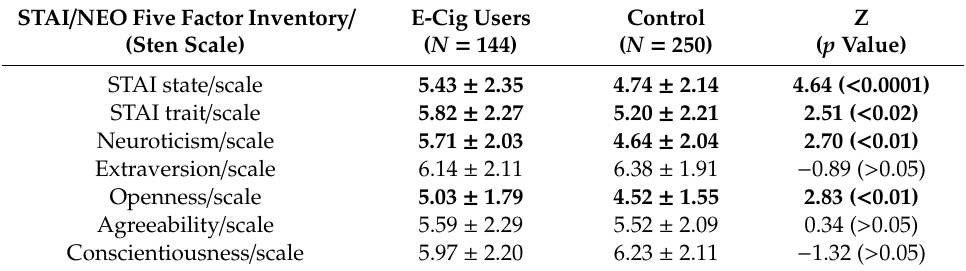
Table 2. STAI and NEO Five Factor Inventory results in controls and e-cigarette users. STAI / NEO Five Factor Inventory